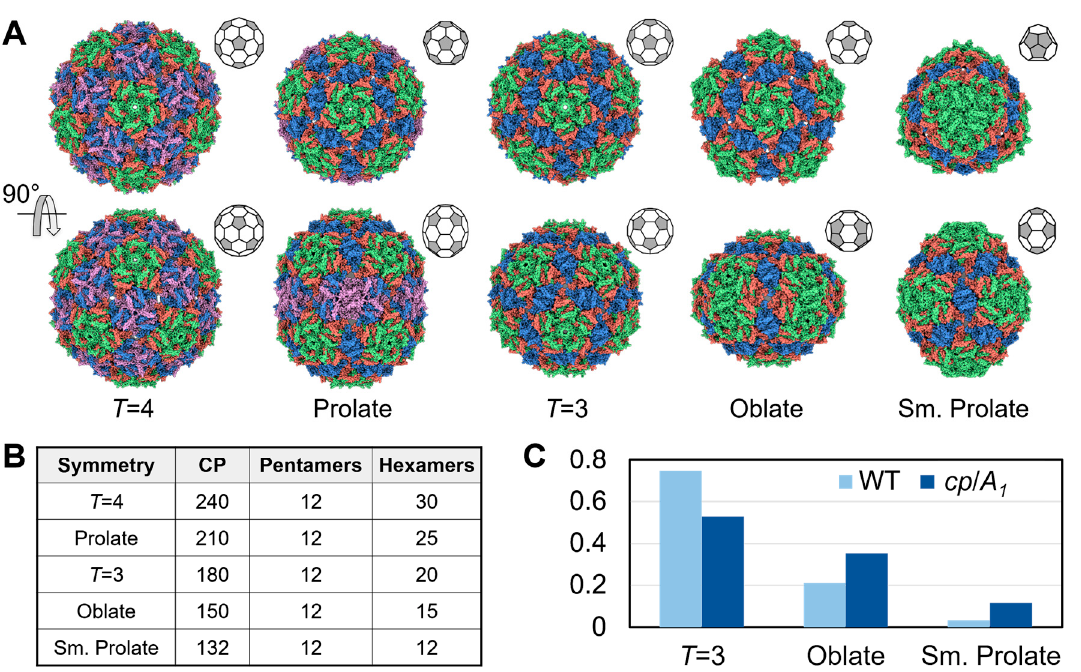
Figure 3. Structures of the Q β VLPs. ( A ) Top: cryo-EM structures of the Q β VLPs of T = 4, prolate, T = 3, oblate, and small prolate symmetries from left to right. The corresponding symmetry cages are drawn with pentamers and hexamers colored grey and white, respectively. Bottom: the same structure horizontally rotated 90 ◦ . ( B ) The table shows the number of CPs, pentamers, and hexamers for each form of the VLPs. ( C ) The population for the T = 3, oblate, and small prolate VLPs produced by the wild-type Q β infection (light blue) and over-expressing the cp/A 1 gene (deep blue). Samples were purified by gel-filtration chromatography.